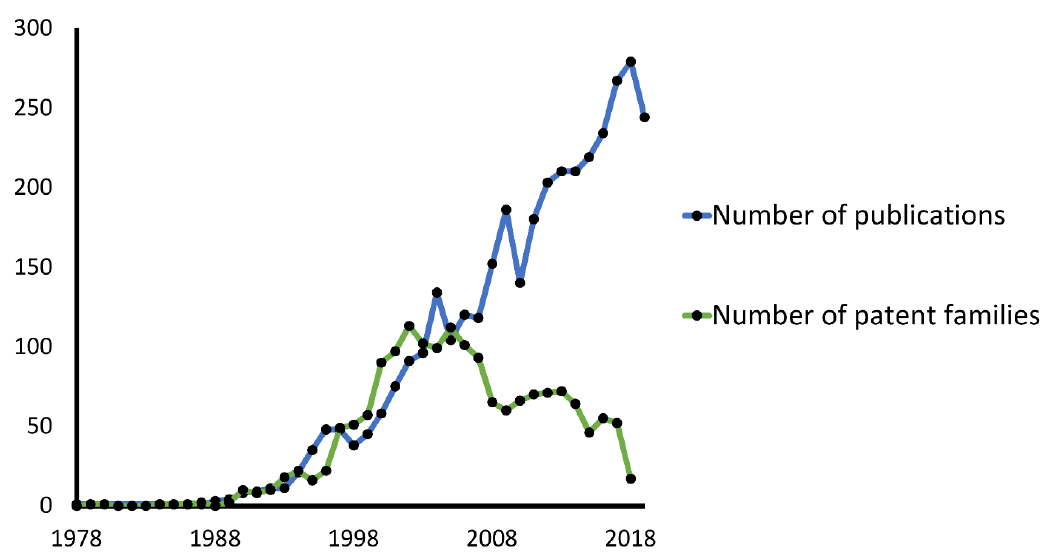
Figure 1. Data search results for: “NMR” and “Drug design” in Scopus (blue) (www.scopus.com) and Orbit patent (orange) (www.orbit.com) databases.